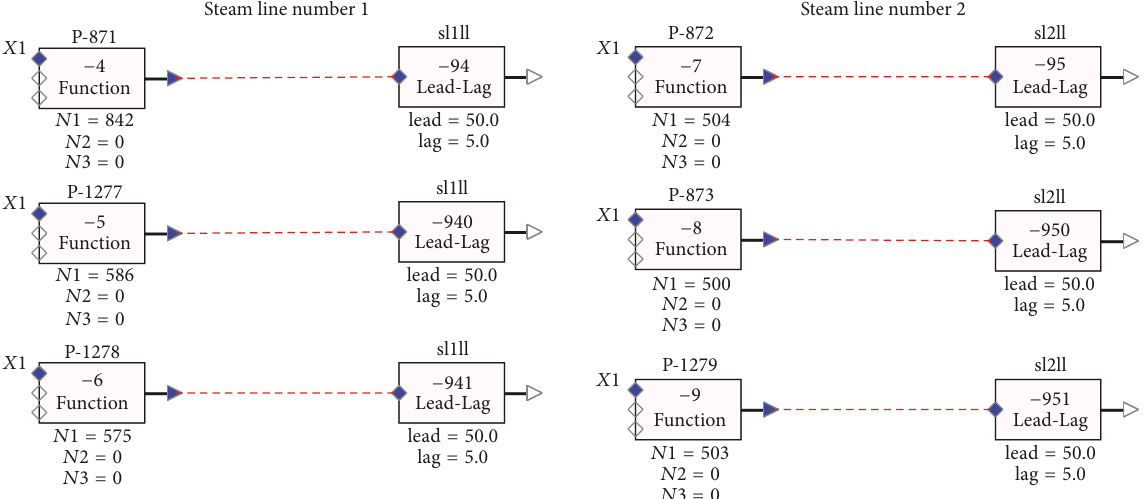
Figure 5: TRACE model for low steam line pressure signal compensation.